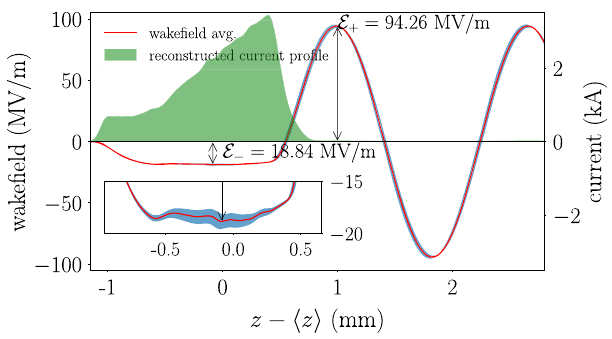
FIG. 18. Wakefields obtained from 100 simulations with jitter in linacs L1, L2, and L39. All cavities are taken to have relative jitter in accelerating voltage of 0.01% and phase jitter 0.01°. The red line shows the average wakefield while the blue shaded region represents the fluctuation of wakefields due to jitter over 100 random realizations of the linac settings. The average transformer ratio is 5 . 00 (cid:4) 0 . 05 . The reconstructed current profile (green- shaded curve) is obtained numerically using Eq. (4).